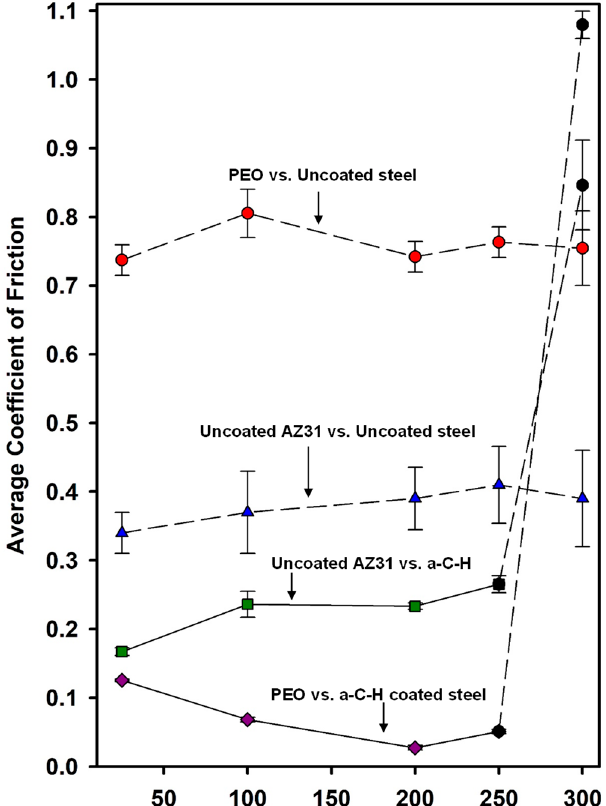
Figure 3. Changes in steady-state COFs of the PEO coated AZ31 running against uncoated and a-C-H coated 52100 steel at room and elevated temperatures. The COFs of a-C-H against uncoated AZ31 are also given. Each point represents an average value of COF calculated from three tests conducted at a given temperature. Dotted line indicates that no steady-state COF was attained. The solid line indicates the experimental conditions where the steady-state COF was